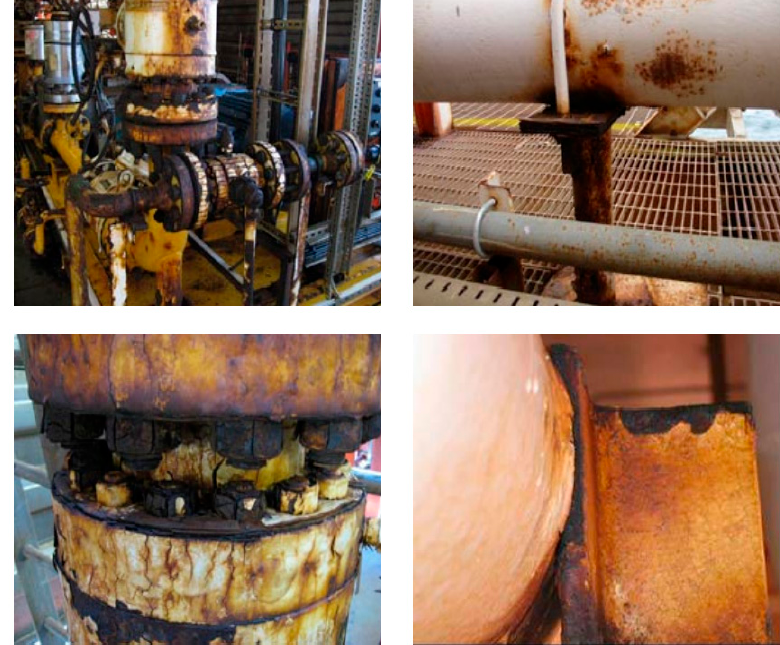
Figure 2. Example of corrosion effect on bolts, valves, flanges, piping, and pipe support [7].